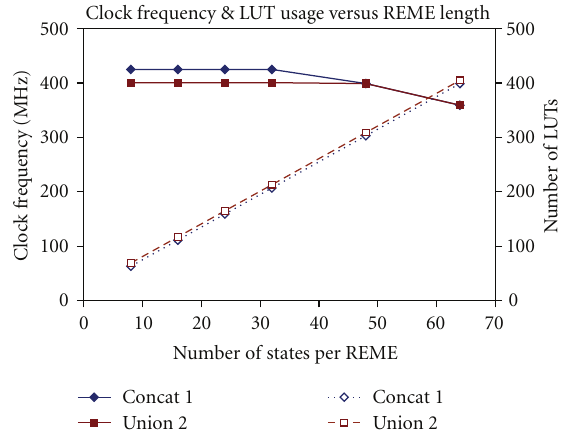
Figure 11: Clock frequency and LUT usage of group of 6 identical synthetic REMEs versus length of every REME. Solid lines (left scale) are clock frequencies; dashed lines (right scale) are number of LUTs.